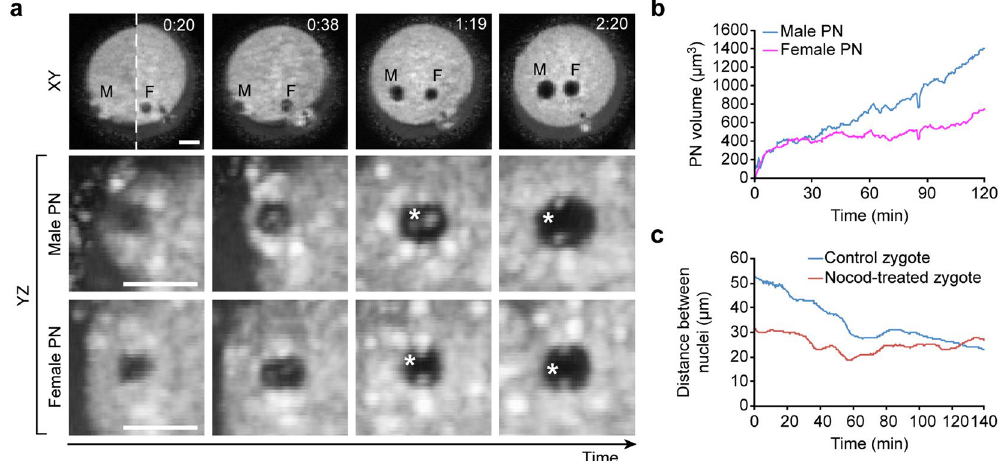
Figure 5. Formation and movement of zygotic nuclei visualized by OCM. ( a ) Formation of male (M) and female (F) pronuclei in mouse zygotes. OCM images (XY plane) selected from the time-lapse recording obtained with DTIsp #4 protocol are presented using minimum intensity projection of 15 μ m-thick slices (Procedure #2). Pronuclei cropped in YZ plane from the same time points as the XY projections are shown without intensity averaging (Procedure #1) and reveal formation of nucleoli (marked with asterisks). ( b ) Changes in the pronuclei volume were measured with OCM for 2 hrs, with 30 sec intervals between the acquisition of each 3D dataset. Each 3D dataset was automatically segmented using custom algorithms to extract the voxels belonging to pronuclei and to calculate the volume and position of each pronucleus. A gradual increase in volume of both female and male pronucleus is clearly visible. ( c ) Changes in the distance between pronuclei recorded in control and nocodazole-treated zygotes. Zygotes were filmed for 2.5 hrs, with 30 sec intervals between the acquisition of each 3D dataset. Recordings started at approximately the same moment after fertilization, as judged by morphological markers of the post-fertilization events (i.e. presence of the fertilization cone – a protrusion above the sperm chromatin, and formation of the second polar body). The initial position of nuclei in control and nocodazole-treated zygotes was different (the initial distances were 50 and 30 µ m respectively) due to the different sperm entry-point. In control zygotes the distance between pronuclei clearly decreases over time, whereas in nocodazole-treated zygotes it stays the same. Scale bars represent 20 µ m. See also Supplementary Videos 11–14 for more images of these